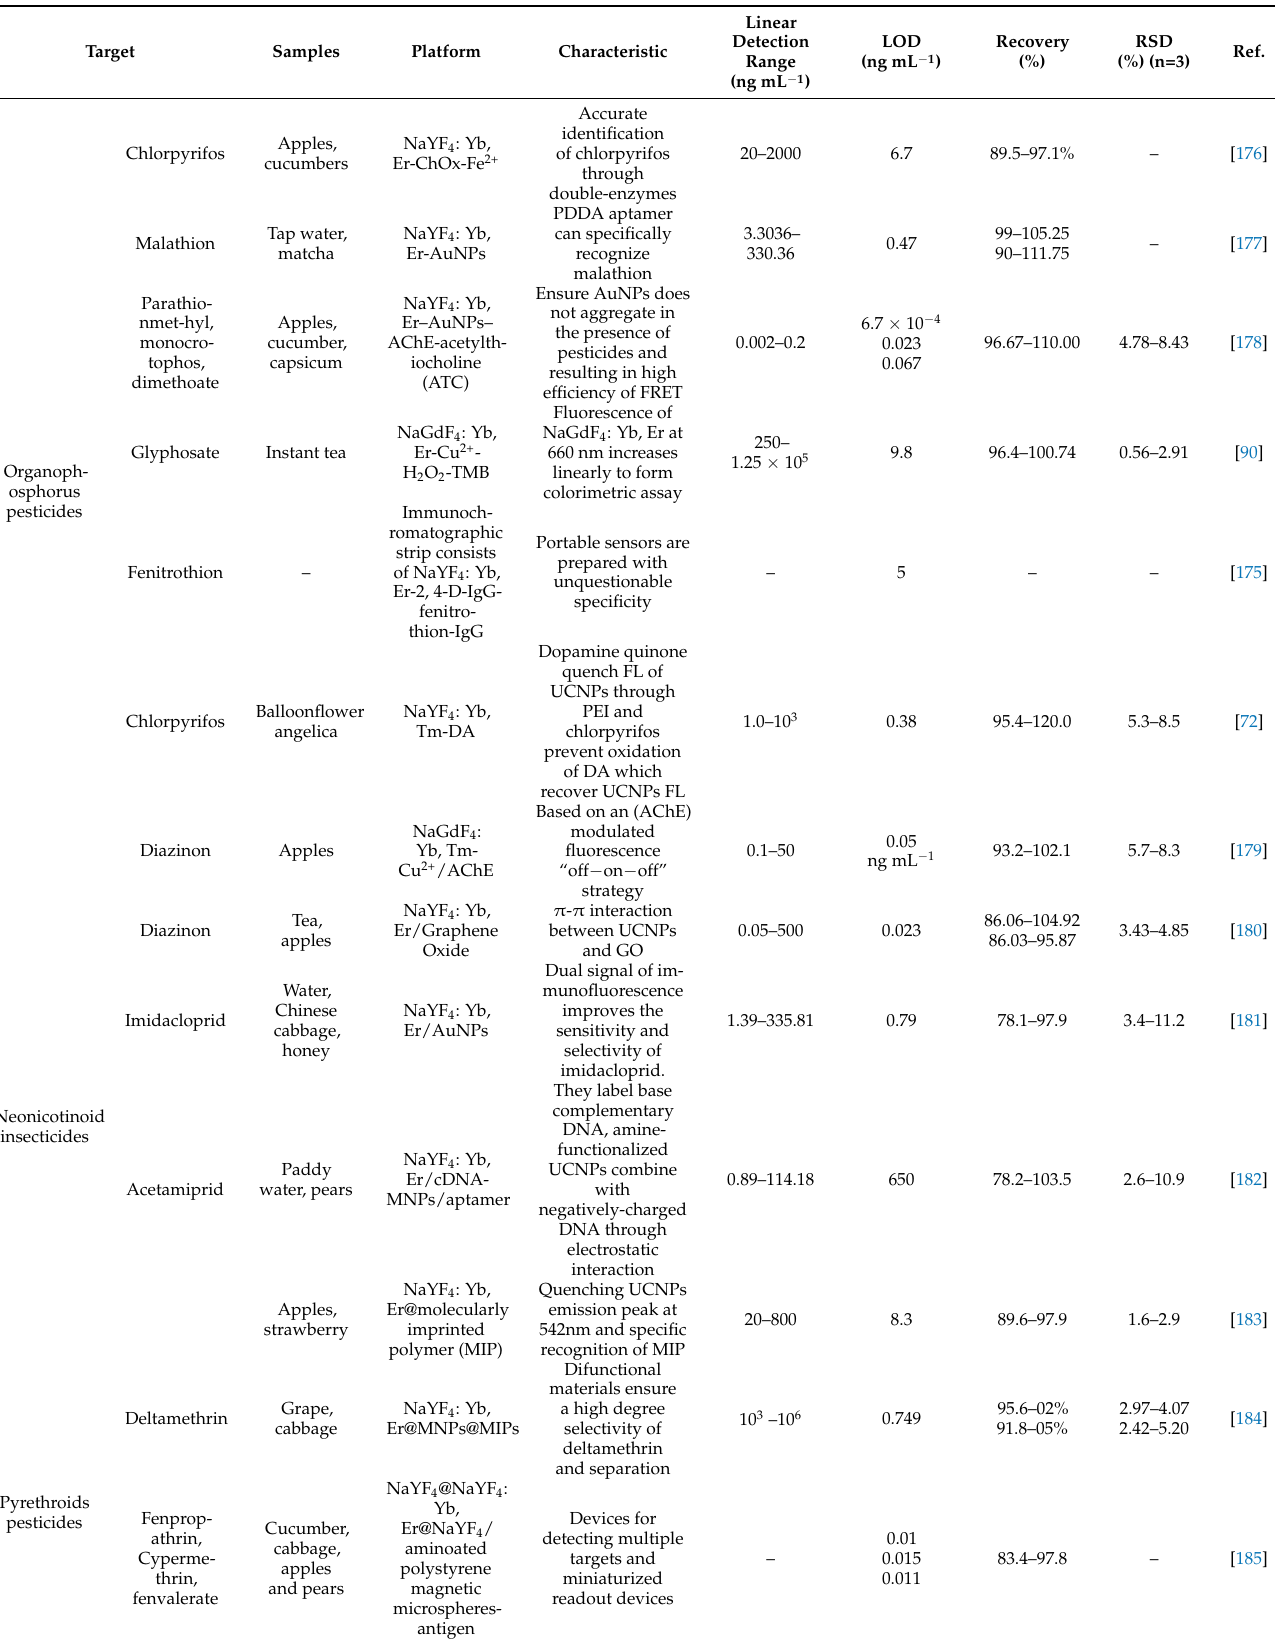
Table 6. Application of UCNPs platform in food